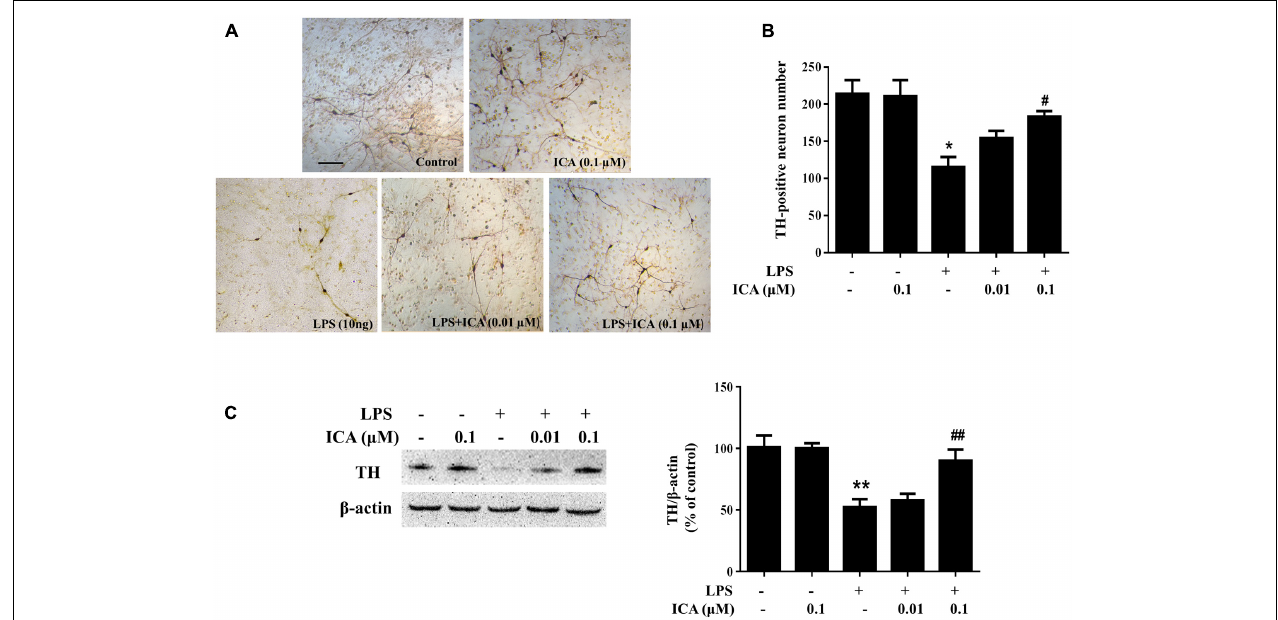
FIGURE 1 | Icariin (ICA) protected DA neurons against LPS-induced neurotoxicity in vitro . Rat primary midbrain neuron-glia cultures were pretreated with ICA (0.01 and 0.1 µ M) for 30 min before LPS (10 ng/ml) treatment. Seven days later, ICA-produced neuroprotection was analyzed by the immunocytochemical analysis (A) and TH-positive neuron counting (B) . Representative images of immunostaining from three individual experiments were shown. Scale bar: 100 µ m. The level of TH protein expression in the neuron-glia co-cultures was detected via western blot assay (C) . The ratio of densitometry values of TH with β -actin was assessed and normalized to each respective control group. Results were the mean ± SEM from three independent experiments performed in triplicate. ∗ p < 0.05 or ∗∗ p < 0.01 compared with the control cultures; # p < 0.05 or ## p < 0.01 compared with LPS-treated